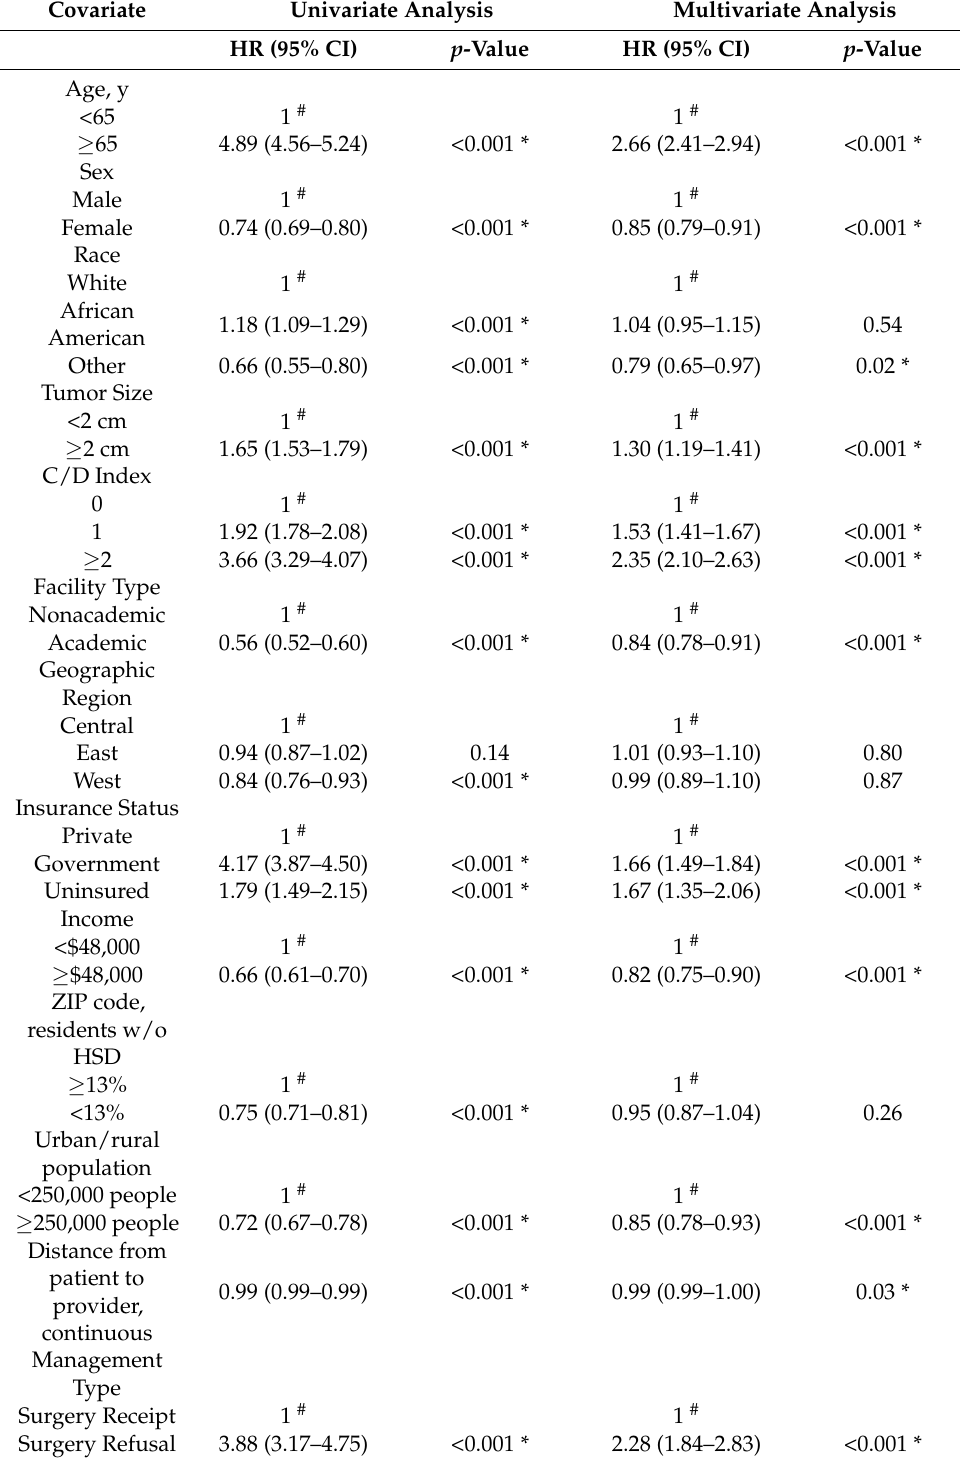
Table 3. Multivariate cox proportional-hazard analysis of clinical and sociodemographic factors of PA